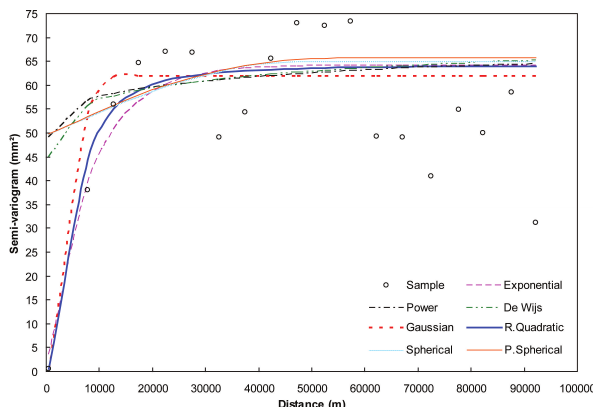
Fig. 2. Sample semi-variogram of daily rainfall (7 August 1991) with seven models fitted: the Rational Quadratic Model is best